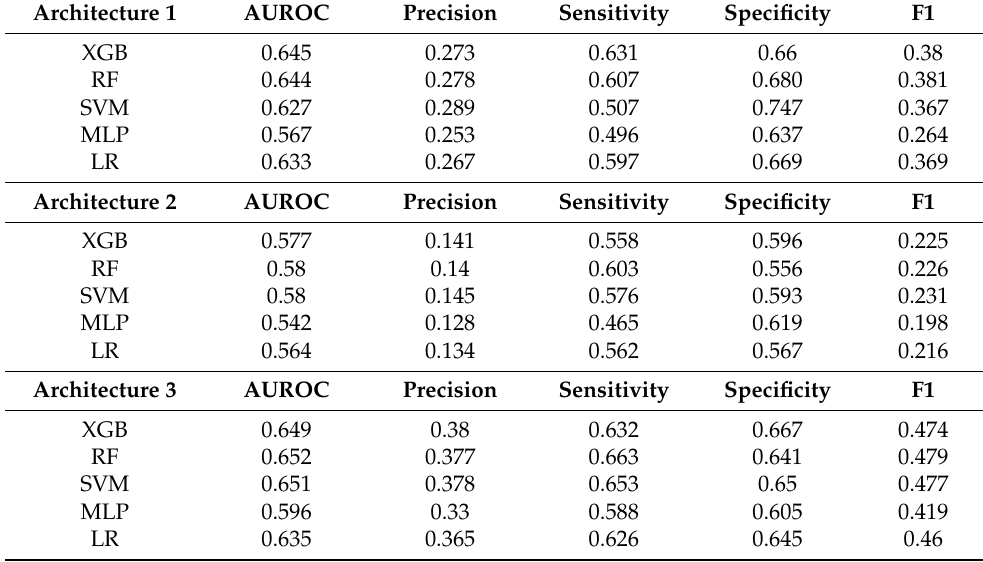
Table 3. Average CV scores for the models trained with the data subset including all ages (architec- ture 1), with the data subset for ages 0 to 5 years (architecture 2) and with the data subset for ages 6 to 14 years (architecture